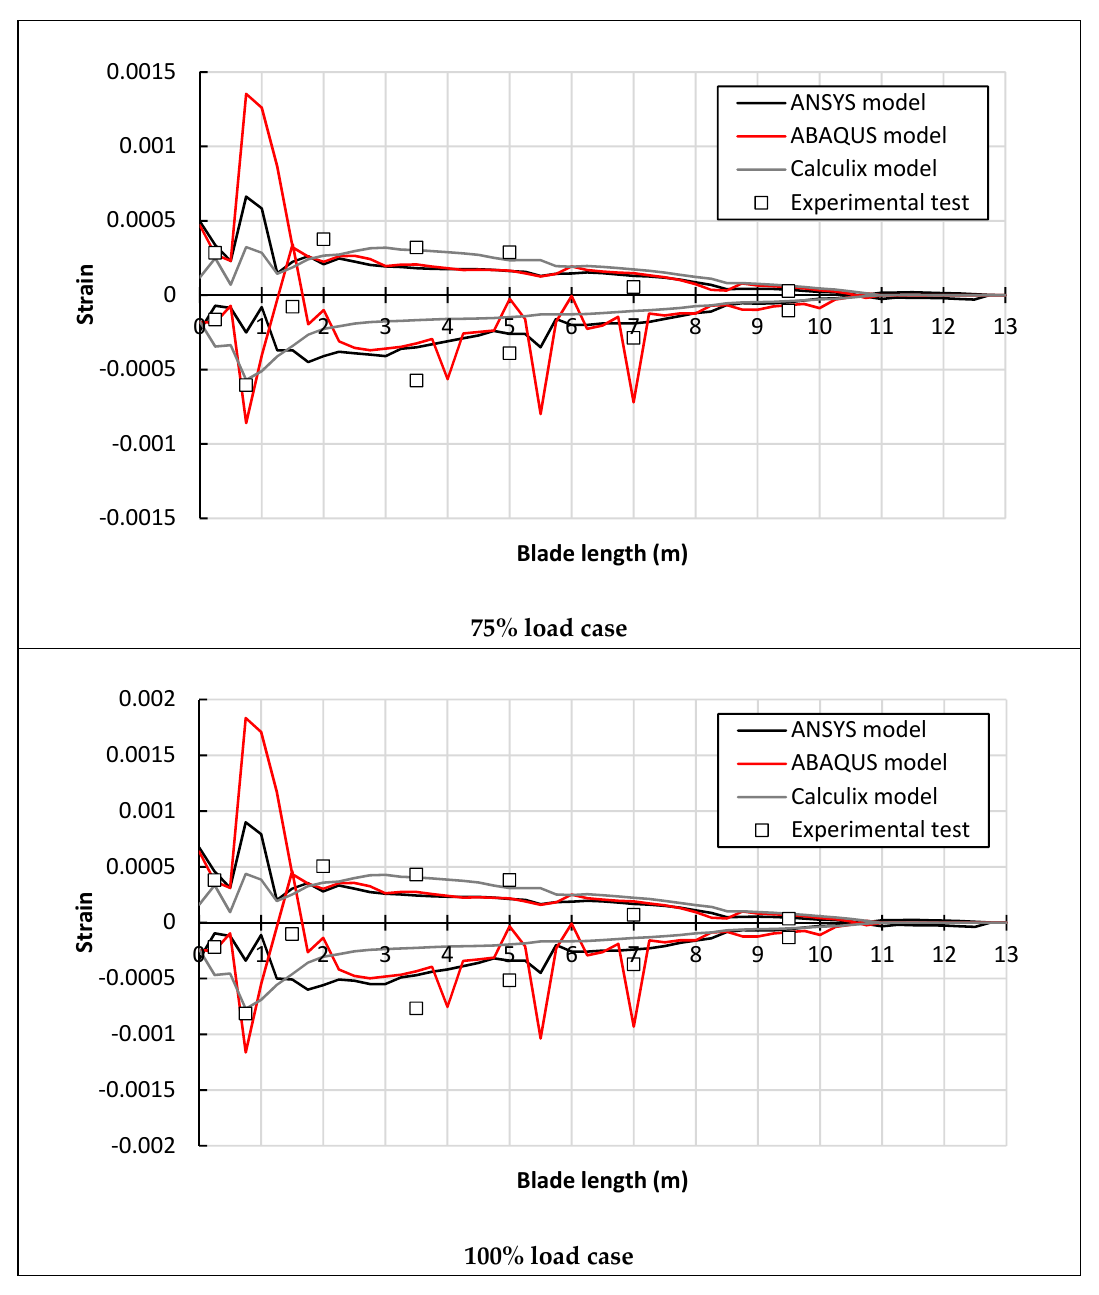
Figure 13. Comparison between the results from the 3 numerical models (ABAQUS, ANSYS, and CalculiX) and the results from the experimental static test showing the strain along the leading edge and trailing edge of the blade (showing the leading edge (positive strain) and trailing edge (negative strain)) on the outer surface along the blade length for each of the load cases in the edgewise direction.